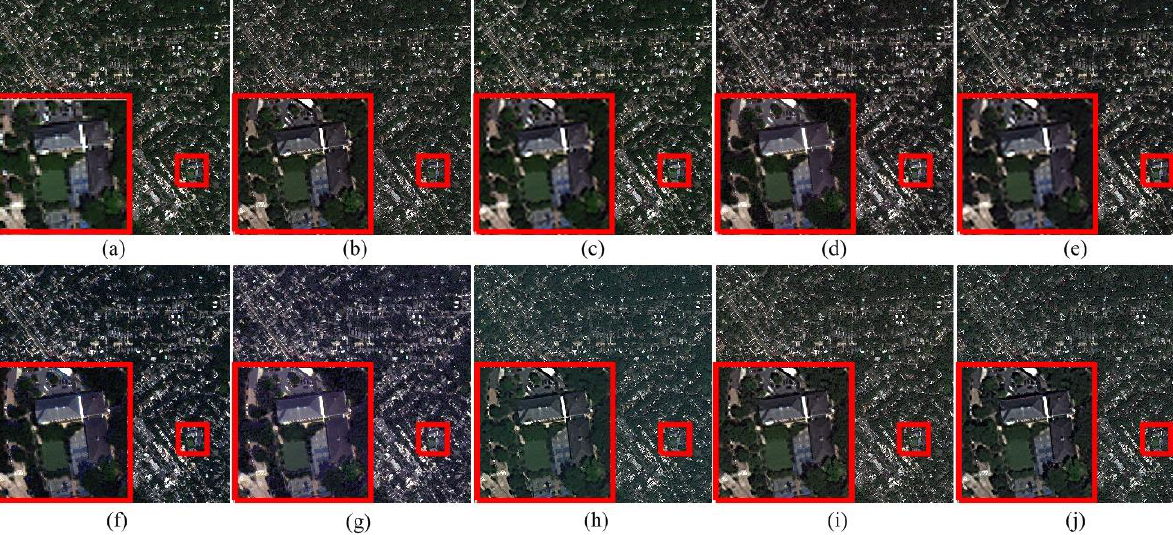
Figure 4. The pansharpening result of Washington dataset. (a) original MS image, (b) proposed PSBP method (c) EXP method (d)